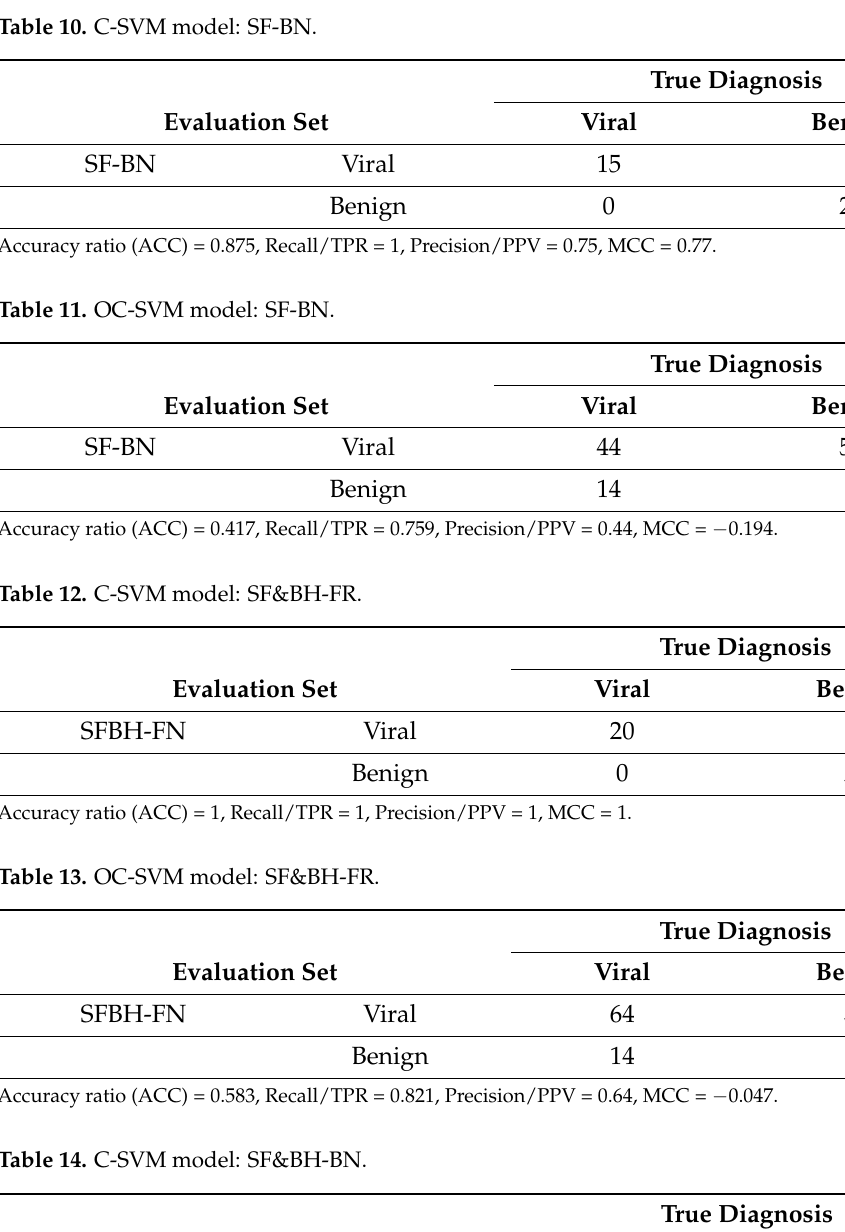
Table 9. OC-SVM model: SF-FR. True Diagnosis Evaluation Set Viral Benign SF-FR Viral 67 33 Benign 14 6